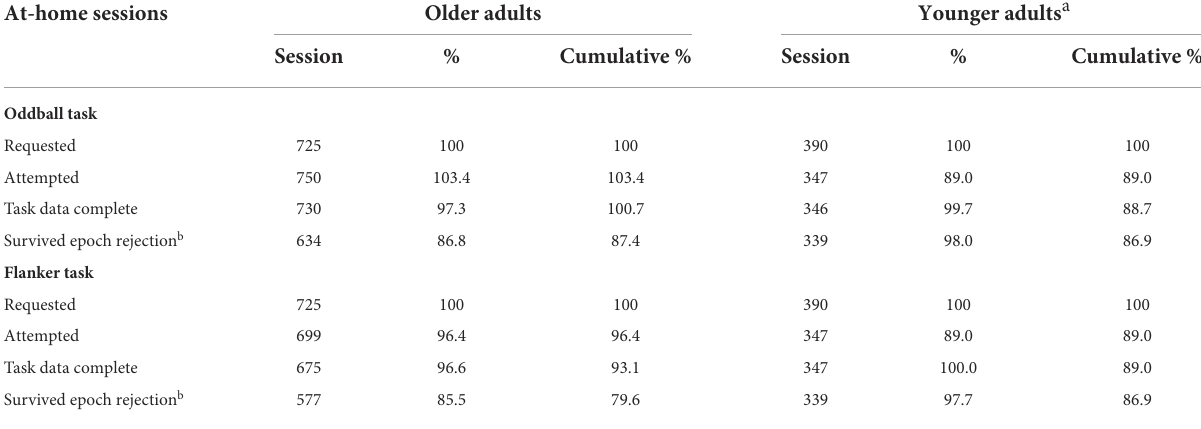
TABLE 3 Number of available at-home sessions at each step of the data collection analysis, including percentage retained relative to previous step. At-home